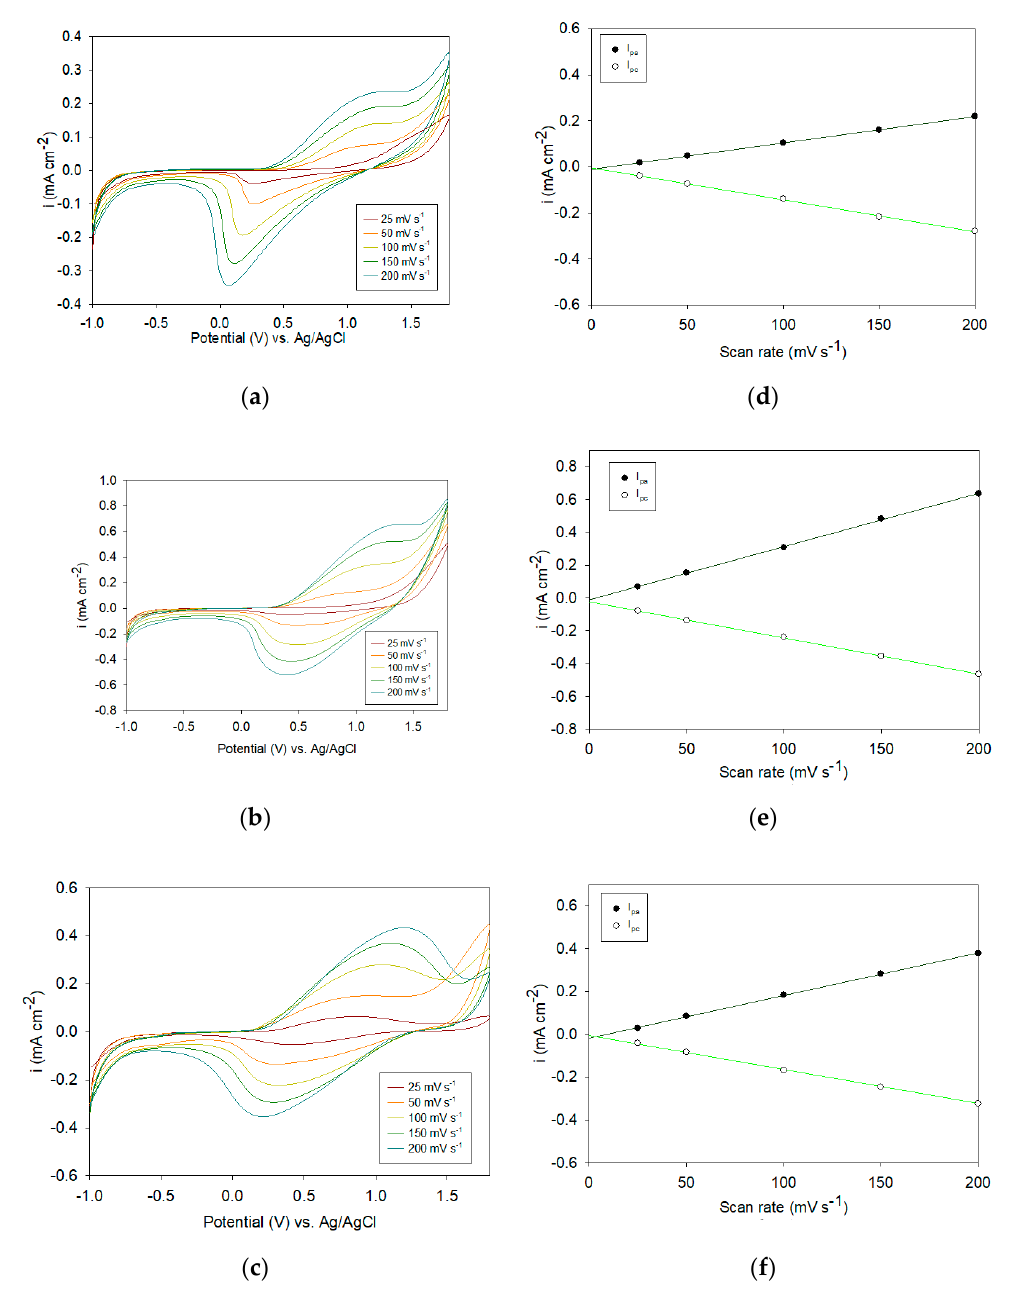
Figure 4. CV plots of: ( a ) PTTPP; ( b ) P(TTPP- co -DTC); and ( c ) P(TTPP- co -DTP) electrodes at different scan rates in 0.1 M lithium perchlorate / acetonitrile. The relationship of i vs. v of: ( d ) PTTPP; ( e ) P(TTPP- co -DTC); and ( f ) P(TTPP- co -DTP)